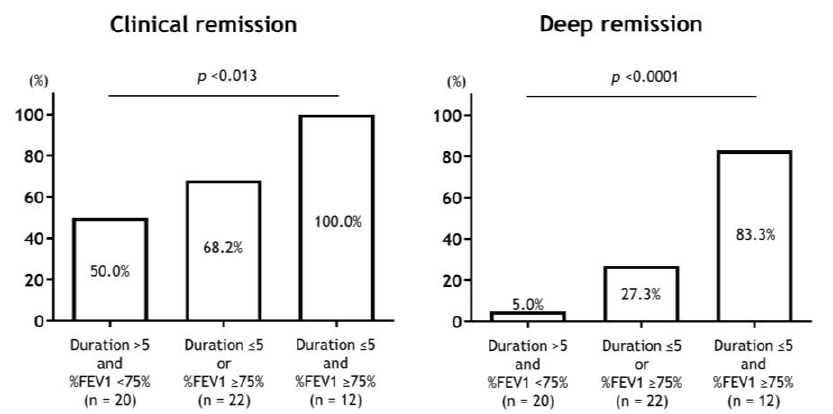
Figure 3. Achievement rates of clinical and deep remission according to the levels of asthma duration and airflow limitation. There was a significant difference in the achievement rate of clinical and deep remission according to the asthma duration and airflow limitation.